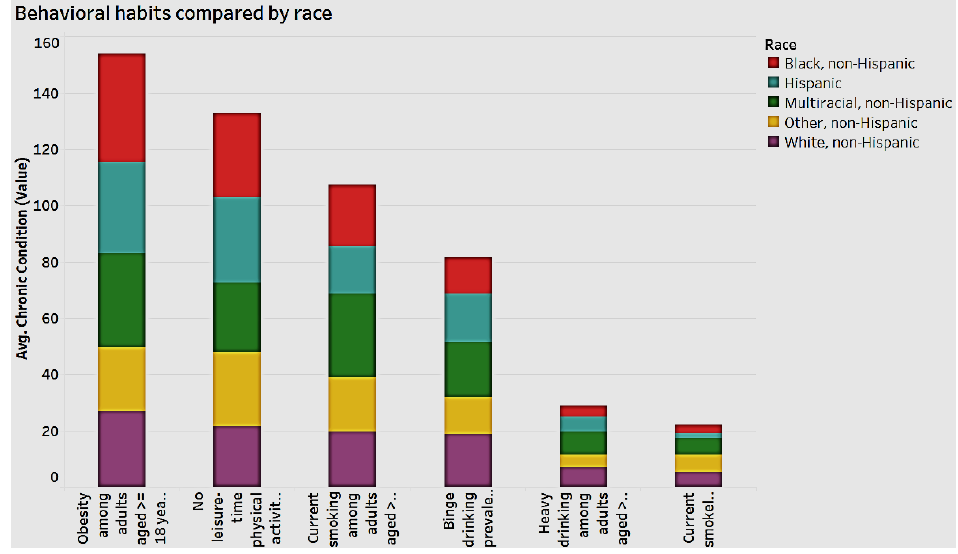
Figure 11. Behavioral habits by race.